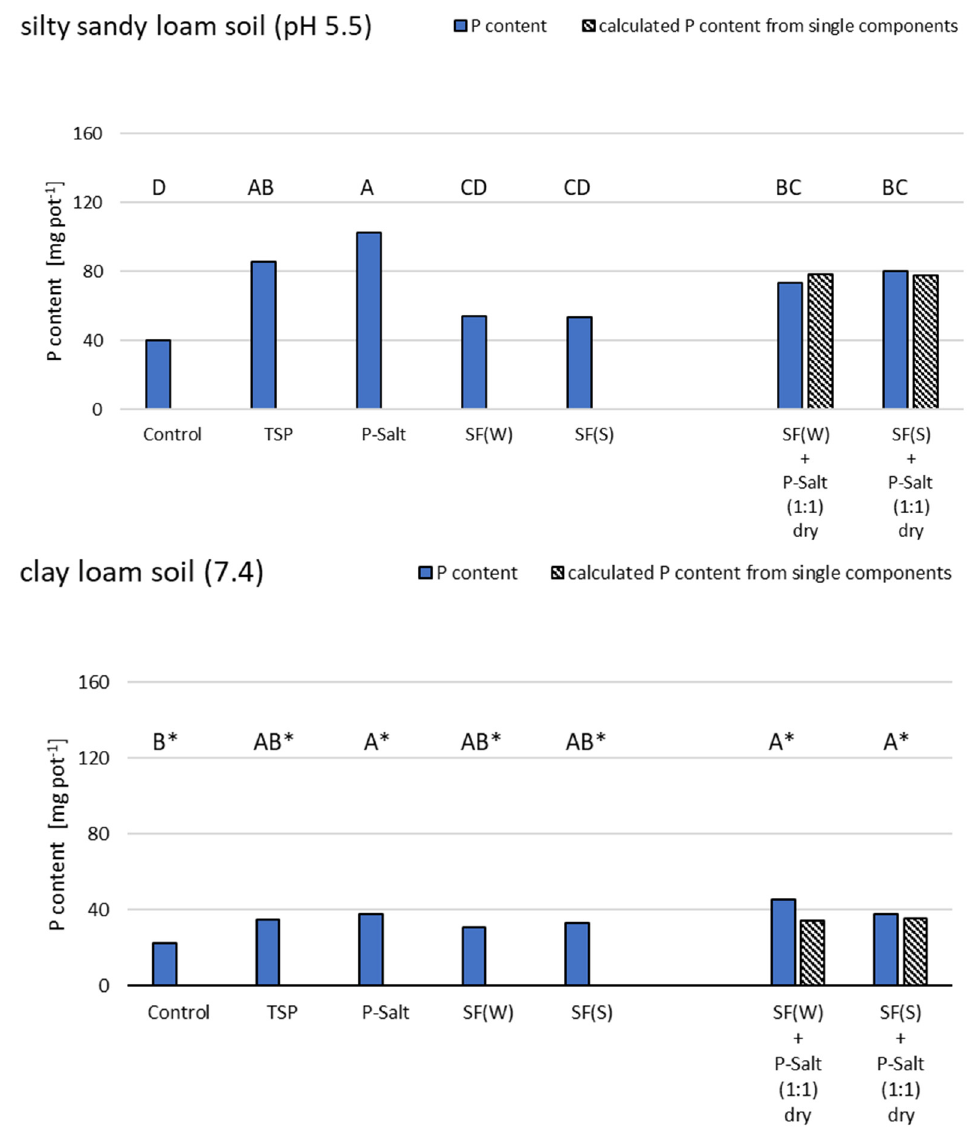
Figure 5. Total phosphorus content (P content) after 84 days in mg P/pot of ryegrass, initially treated with different recycled fertilizers in a total dose equivalent to 150 mg P (kg soil) − 1 followed by maize cultivation (50 days) and harvest; fractions tested: P-Salt, SF(W), SF(S), and two different combinations of them, compared to unfertilized control and TSP. Based on the total fertilizer dose corresponding to 150 mg P (kg soil) − 1 , designation (1:1) means that fertilizers were applied with a mass portion of SF (W or S) containing 75 mg P (kg soil) − 1 + a mass portion of P-Salt containing 75 mg P (kg soil) − 1 . Ryegrass plants were cultivated for 84 days, with a first harvest cut after 56 days, and a second cut after 84 days. Data are means of four replicates each. Different letters denote significant differences (two factorial Tukey-test with p ≤ 0.05), and significant differences between the soils are indicated by an asterisk (*).